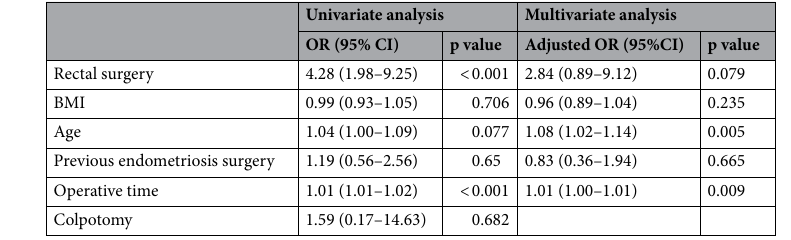
Table 4. Logistic regression predicting post-operative complication: univariate and multivariate